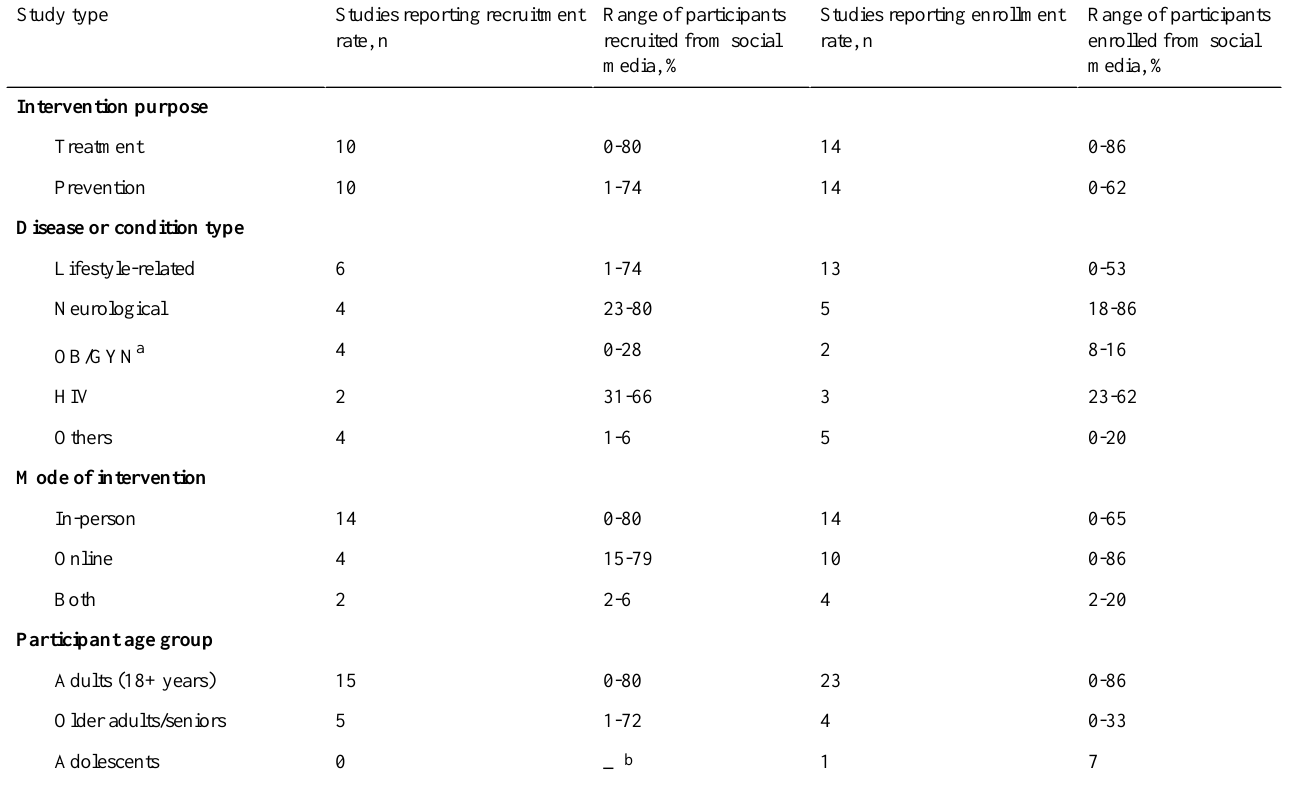
Table 3. Social media recruitment and enrollment rates by study type.